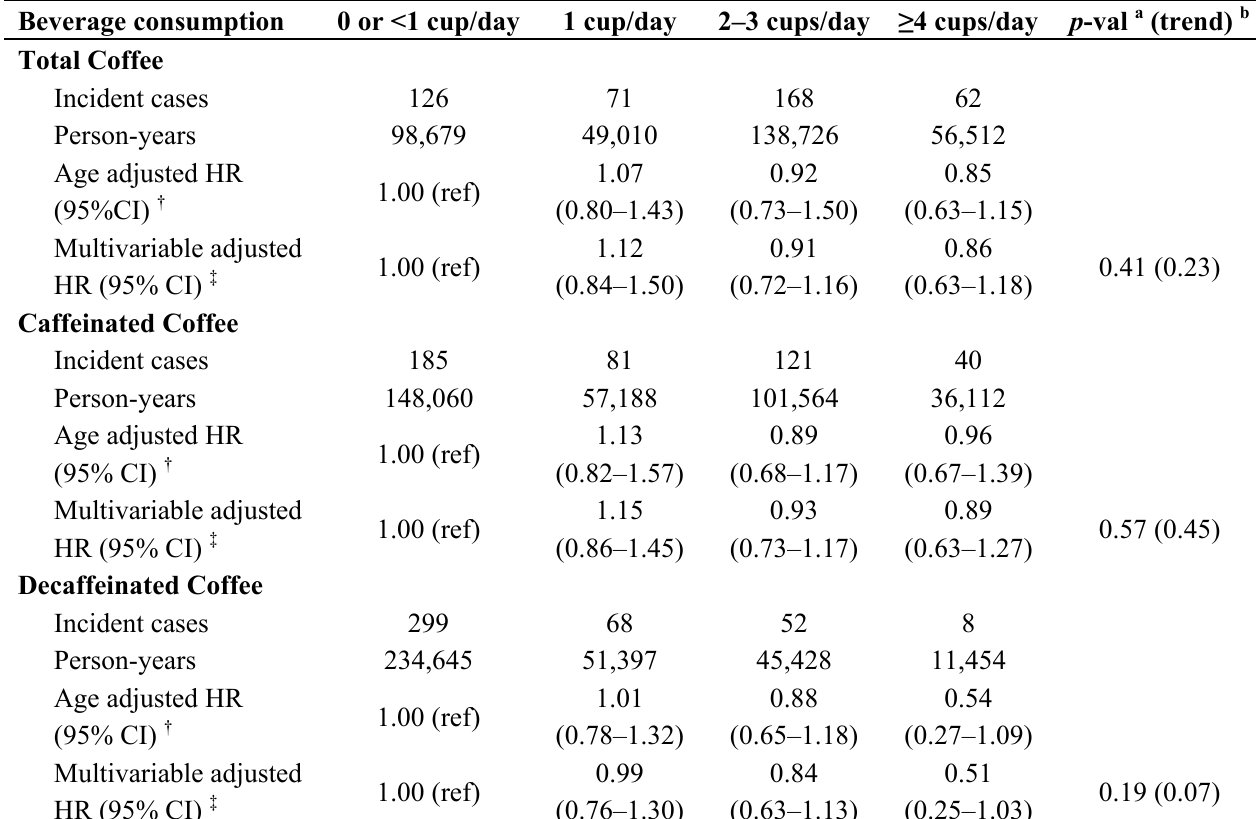
Table 2. Multivariable adjusted hazard ratios (HRs) and 95% confidence intervals (CIs) of total coffee, caffeinated coffee and decaffeinated coffee in relation to endometrial cancer in the Women’s Health Initiative Observational Study ( N = 45,696).